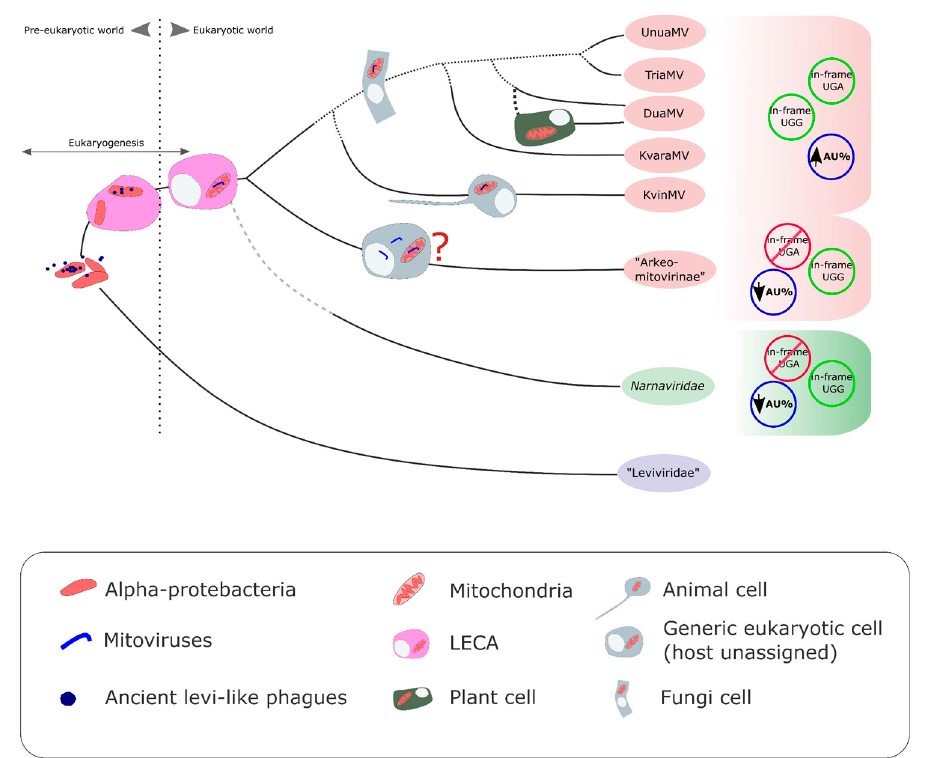
Figure 3. A comprehensive picture of the origin and evolutionary scenario of Mitoviridae and Nar- navridae . The scheme has temporal directionality from left (past) to right (present). Lines represent the ancestor–descendant relationship of the main mitovirus lineages based on the results reported in the present work and those reported by Mitovirus SG [20], Nibert et al. [6] and Jacquat et al. [21]. Solid lines have phylogenetic support from protein sequences. Dotted lines do not have a good topological phylogenetic resolution. The green line indicates the evolutive origin of the monophyletic lineage of plant-replicating mitoviruses (blue string within the mitochondria) and endogenized plant mitoviruses (blue string within the nucleus). This lineage together with a lineage of mitoviruses that replicates in fungi (within mitochondria) constitute the genus Duamitovirus (DuaMV). Moreover, the genera Unuamitovirus (UnuaMV), Triamitovirus (TriaMV) and Kvaramitovirus (KvaraMV) are exclusively made up of fungal mitoviruses. “Kvinmitovirus” (KvinMV) is the recently proposed mitoviruses genus. These five clades are included in the proposed subfamily “Mitovirinae”, a sister clade of “Arkeomitovirinae”. There is no evidence concerning the authentic host of the putative “arkeomitoviruses”. The ancestor common to all mitoviruses was replicating within the mitochondria of the last eukaryotic common ancestor (LECA). This originated from levivirus-like bacteriophages that infected alpha-proteobacteria (mitochondrial precursors) in the pre-eukaryotic world. During eukaryogenesis, these levivirus-like phages became confined within the endosymbiont organelle (loss of lytic cycle) and evolved to become the ancestor of all mitoviruses by genome reduction. The main ideas of the originally proposed evolutive scenario detailed here were taken from Koonin and Dolja [54] and Koonin et al. [55].